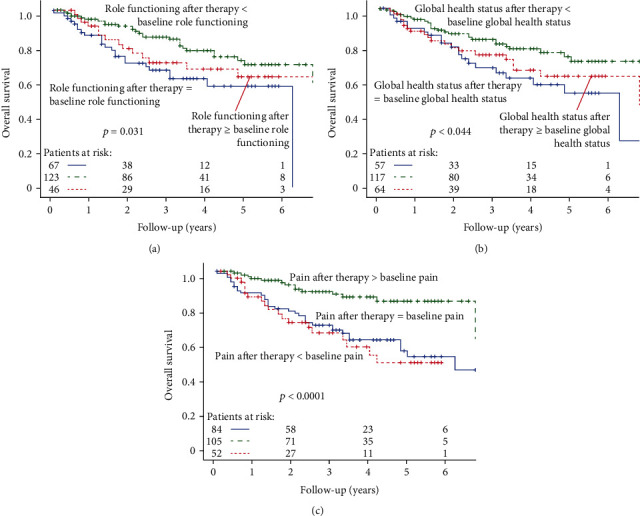
(a–c) Change scores and OS for (a) role functioning, (b) global health status, and (c) pain regarding three groups.